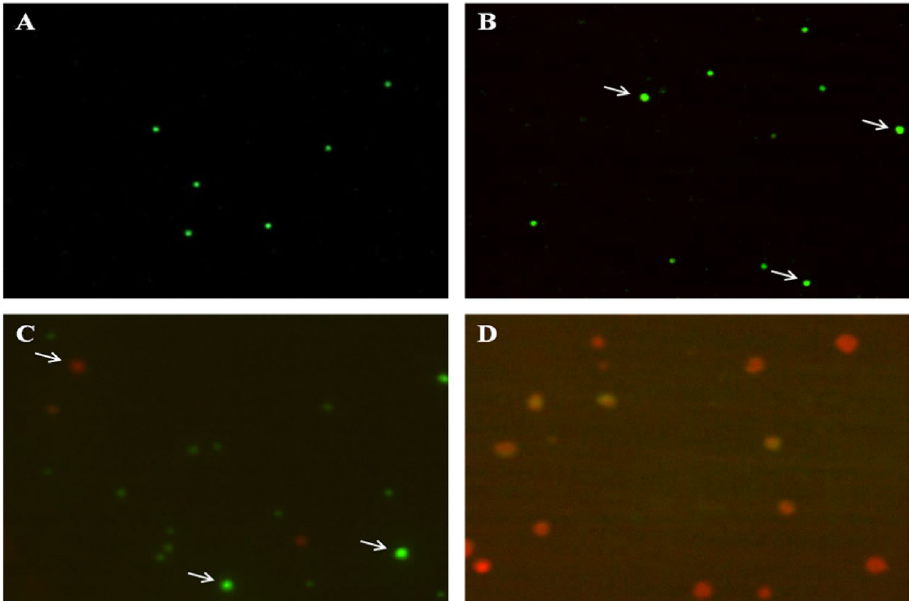
Figure 9. Effect of bioallethrin on nuclear morphology. Fluorescent images of cells double stained with acridine orange and ethidium bromide. ( A ) Control (untreated) and cells treated with ( B ) 50 µM ( C ) 100 µM and ( D ) 200 µM bioallethrin. Lymphocytes were incubated with bioallethrin for 2 h at 37 °C. Visual analysis was done by imageJ2, https:// imagej. net/ Image